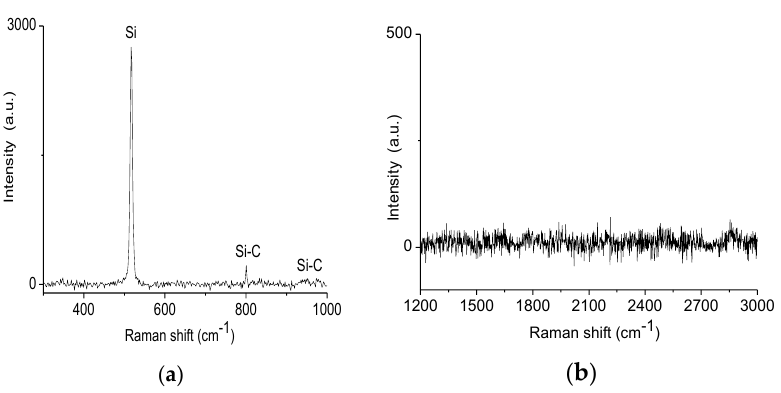
Figure 5. Raman spectra of the dark areas for C2 sample: ( a ) scanning in the SiC range (column A); ( b ) scanning in the graphene range (column B).